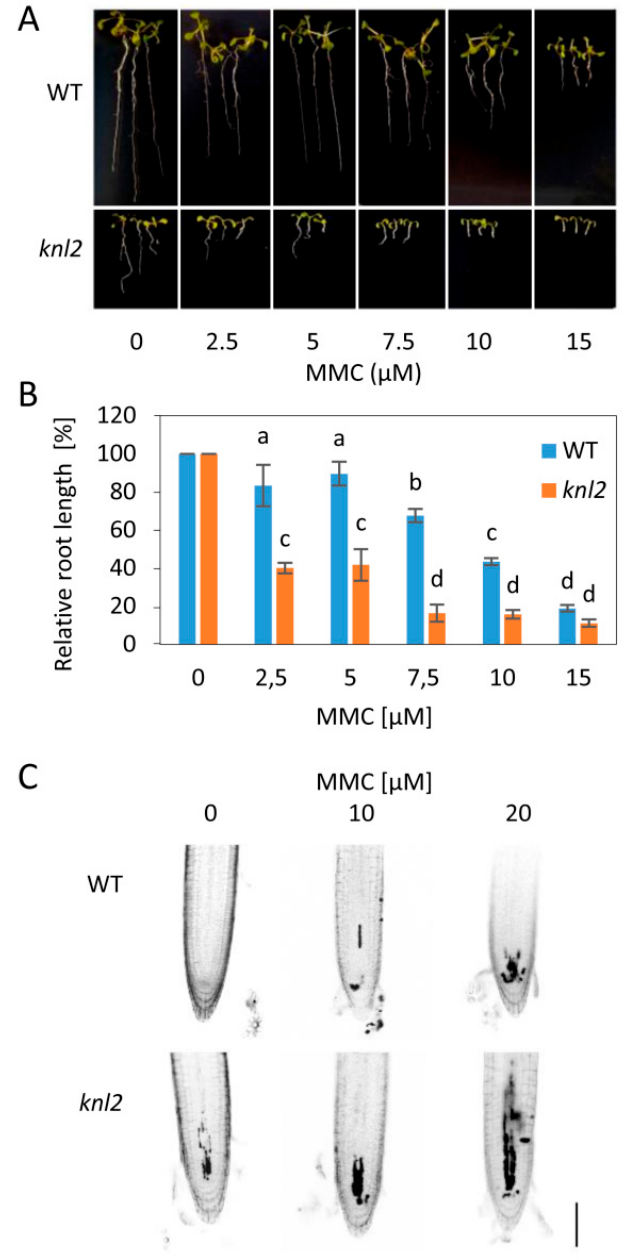
Figure 4. Sensitivity of knl2 plants to DNA damage. ( A ) Representative phenotypes of wild-type (WT) and knl2 plants grown for 14 days on mitomycin C (MMC)-containing media. Bar = 10 mm. ( B ) Quantitative data for plants grown as described in ( A ). Error bars represent the standard deviation between the means of three biological replicates, each represented by 15 to 20 plants. Letters above the bars indicate statistically significantly different groups in ANOVA ( p -value ≤ 0.05) and post hoc Tukey‘s test. ( C ) Analysis of propidium iodide (PI) uptake (dark sectors) in roots of WT and knl2 plants. Four-day-old plants were treated with the specified concentration of MMC for 24 h prior to analysis. Bar = 50 µm.